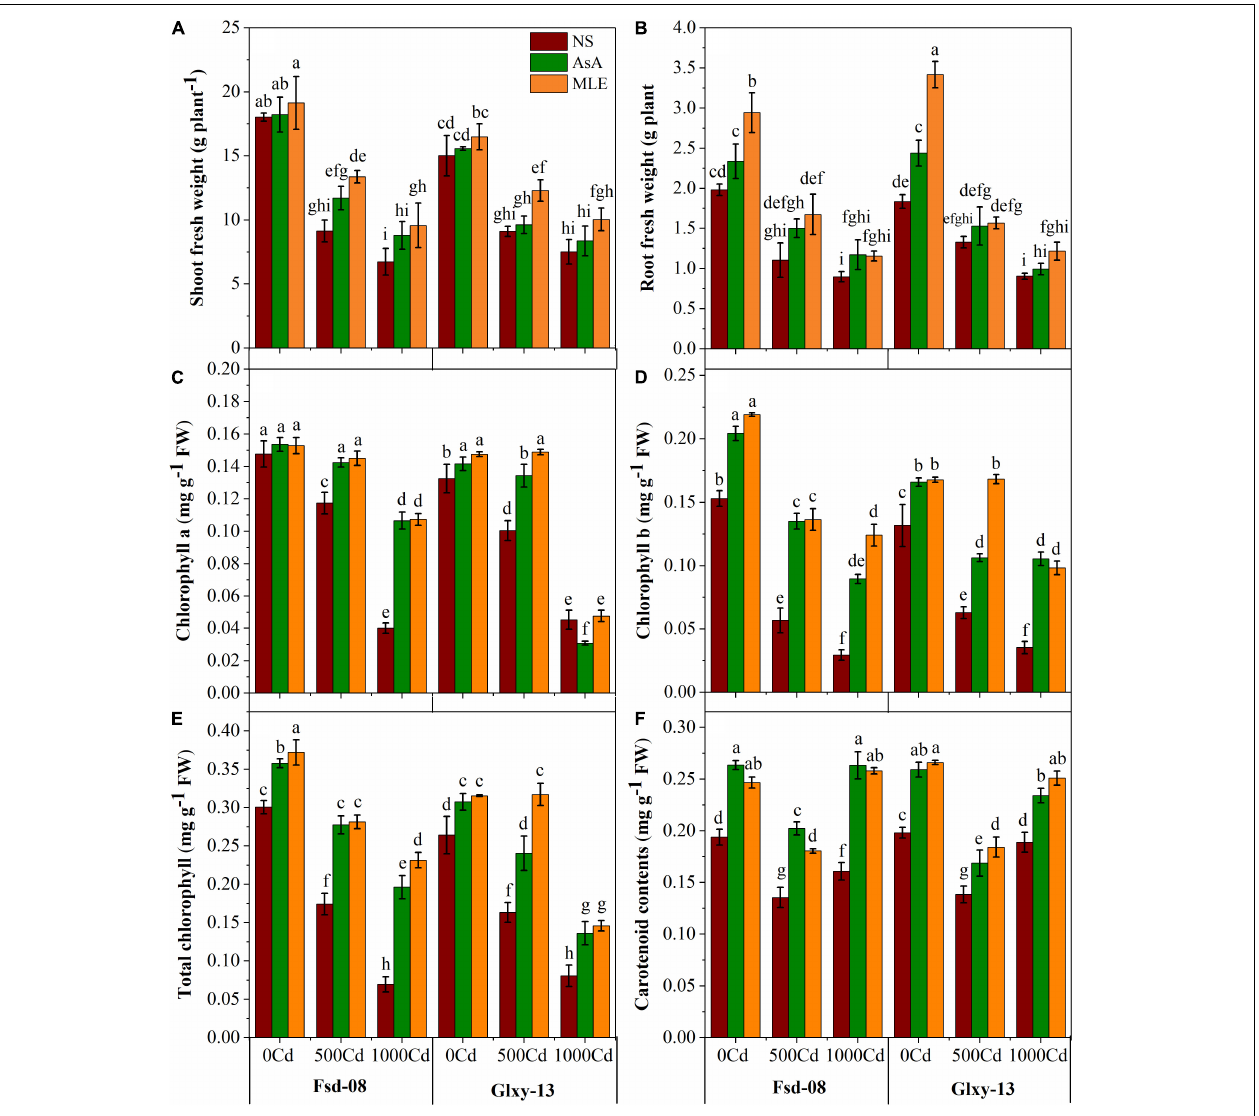
FIGURE 1 | Fresh biomass and photosynthetic pigment responses as (A) shoot fresh weight, (B) root fresh weight, (C) chlorophyll a, (D) chlorophyll b, (E) total chlorophyll, and (F) carotenoid contents, under the foliar spray of ascorbic acid (AsA) and moringa leaf extract (MLE), along with no-spray (NS) in two wheat cultivars (Fsd-08 and Glxy-13) exposed to the cadmium (Cd) toxicity. Different lowercase letters denote significant difference as determined by least significant difference (LSD) test ( p < 0.05, n = 4). AsA and MLE were applied at the rate of 50 mM and 3% (w/v),